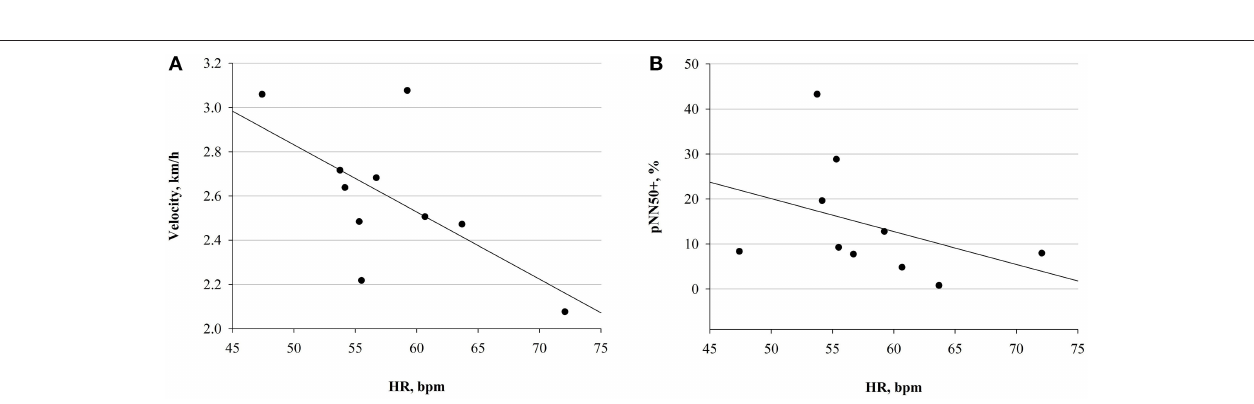
FIGURE 5 | Sympathovagal balance indices in FIN (black line) and in NON (gray line) across time-points. * p < 0.05 vs. PRE within subgroup (One-Way RM ANOVA).